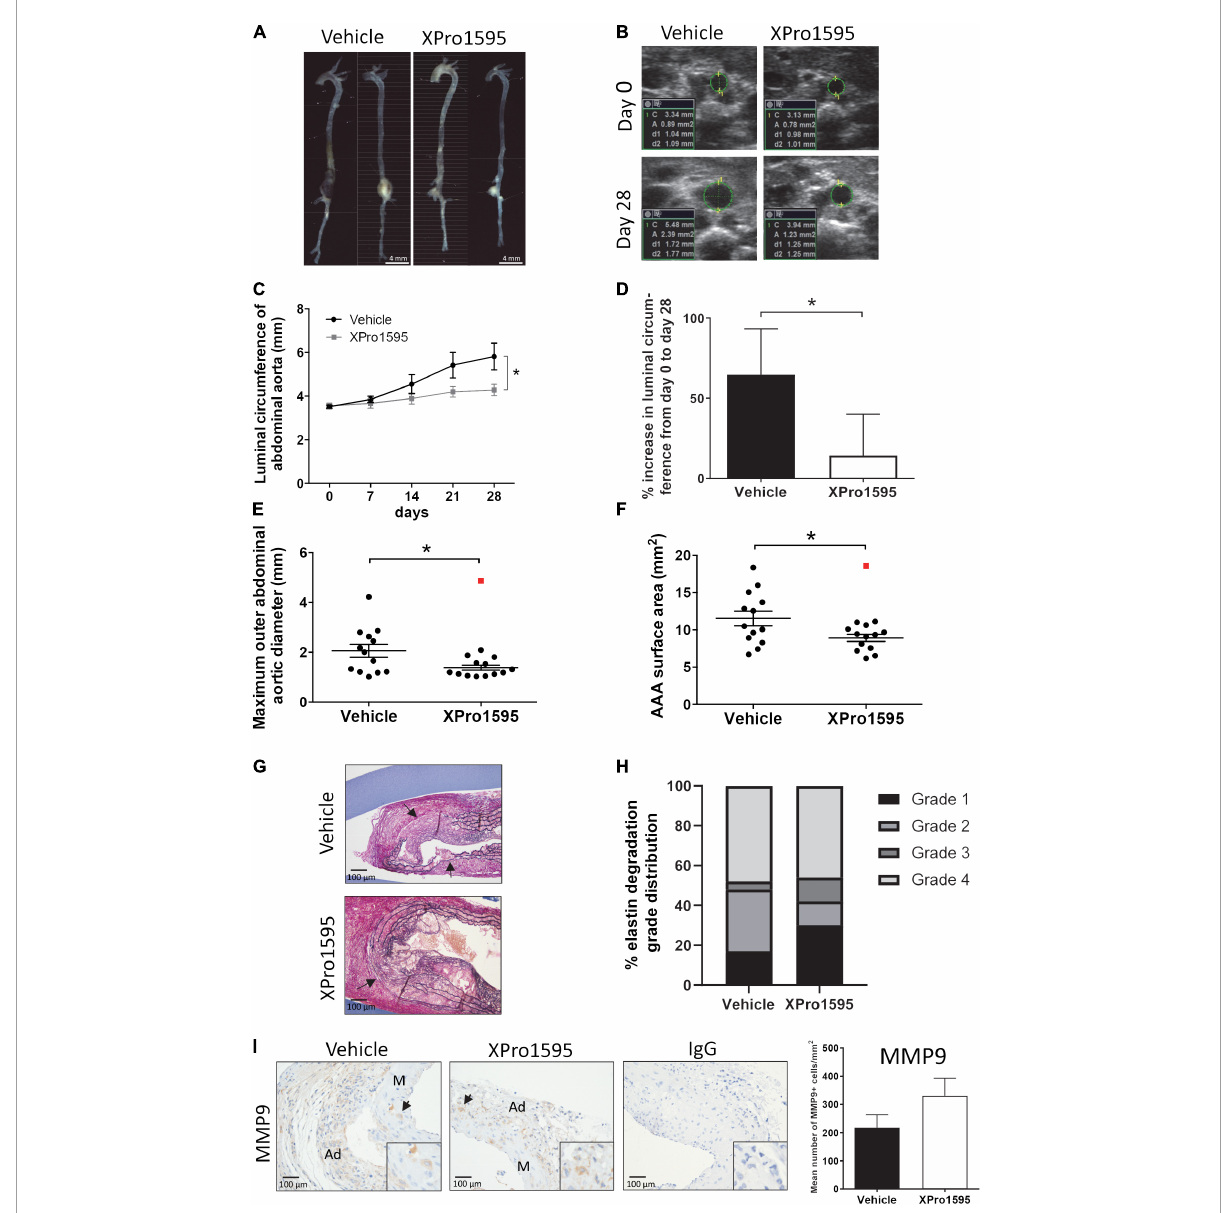
FIGURE6 Inhibition of solTNF prevents ANGII-induced AAA expansion. (A) Representative macroscopic images showing AAA expansion in vehicle (saline) or XPro1595 (2 mg/kg) ANGII-infused Apoe − / − mice. (B) Representative ultrasound images of the abdominal aorta at its maximal inner circumference at day 0 and day 28 of the ANGII-induced AAA from vehicle-treated and XPro1595-treated mice. (C) ANGII-induced AAA expansion assessed by inner abdominal aortic circumference. (D) The percentage change in the maximal inner abdominal aortic circumference from day 0 to day 28 in vehicle- and XPro1595-treated mice assessed by ultrasound€ (E) Ex vivo- measured maximal outer aortic diameter in the two groups. (F) Ex vivo -measured surface area of the AAA treated with vehicle and XPro1595. (G) Representative micrographs of AAA cross-sections stained with Miller’s elastin stain (black) in vehicle- and XPro1595-treated AAAs. Arrows point to rupture of elastic fibers. (H) Medial elastin degradation semi-quantified by a 4-grade system in aneurysms from XPro1595- and vehicle-treated mice. (I) MMP-9 immunoreactivity in cross-sections of vehicle- and XPro1595-treated aneurysms and the representative semi-quantification (number of positive cells/mm 2 ). Black arrowheads indicate positive stained cells. IgG isoform was used as negative control. Results are shown as mean SEM if data passed the D’Agostino and Pearson omnibus normality tests. Mann–Whitney test was applied in D and presented as median with interquartile range as data were non-normally distributed. *Denotes p < 0.05 analyzed by unpaired student t -test for two-group comparison or two-way ANOVA with Bonferroni test for multiple comparisons. Contingency table data in H was analyzed by Fisher exact probability test with Freeman-Halton extension. Outliers were identified by Grubb’s outlier test for normally distributed data and indicated by red squares ( ) and excluded from the statistical analyses. M, media; Ad,